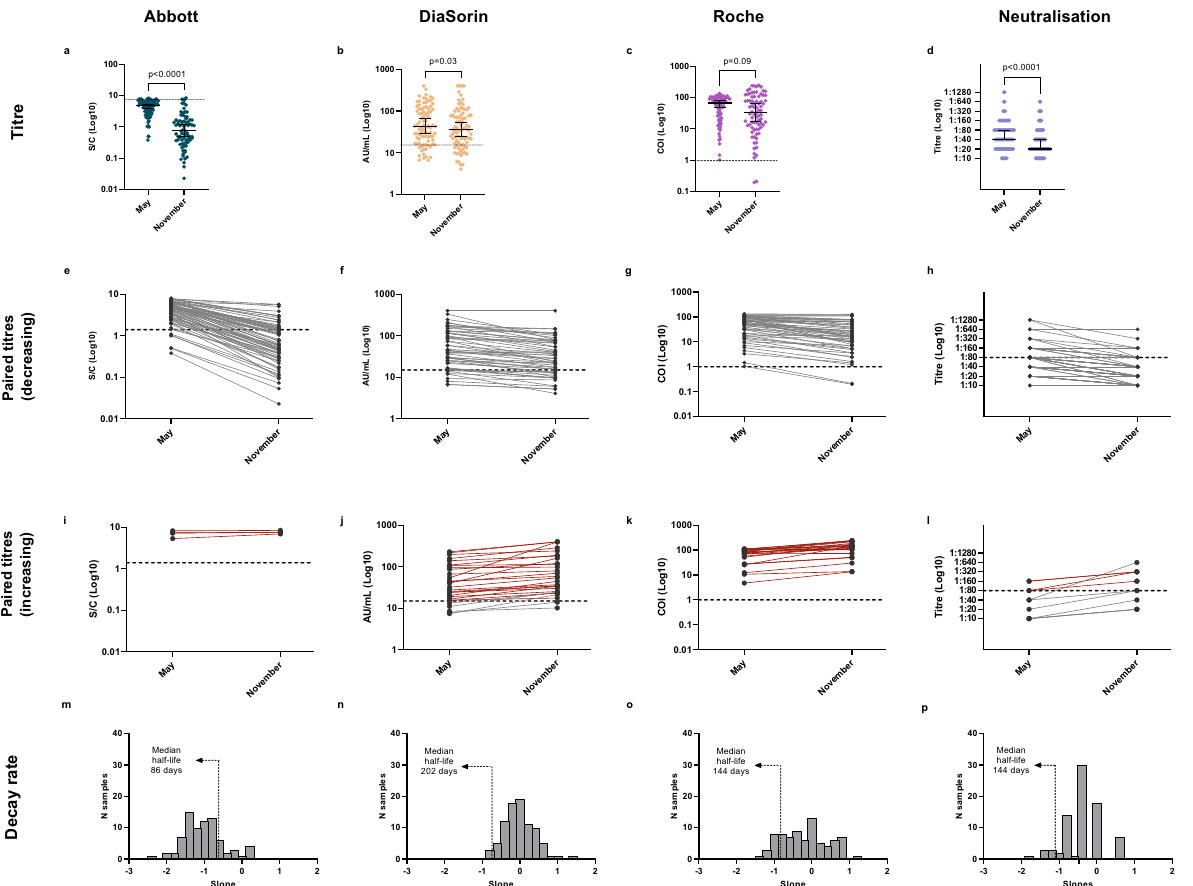
Fig. 3 Antibody titres and dynamics at nine-month post-infection follow up. a – d Observed antibody titres among subjects testing positive in May and re- tested in November by Abbott ( n = 78), DiaSorin ( n = 86), Roche ( n = 78), and micro-neutralisation assays (84), respectively (two-sided Wilcoxon signed-rank test). Only subjects belonging to the baseline ground truth de fi nition have been included. The horizontal line represents the median, the vertical line represents the 95% con fi dence intervals. e – l Antibody dynamics of individual subjects testing positive between May and November, by Abbott, DiaSorin, Roche, and micro-neutralisation. 88.9% (64 out of 72, 95% CI 79.3 – 95.1%), 20.5% (15 out of 73, 95% CI 12.0 – 31.6%), and 35.9% (28 out of 78, 95% CI 25.3 – 47.6%) of individuals showed a reduction of antibody titre of 50% or more by November when tested with Abbott, DiaSorin, and Roche, respectively, whereas 34.7% (25 out of 72, 95% CI 23.9 – 46.9%), 89.0% (65 out of 73, 95% CI 79.5 – 95.1%), and 97.4% (76 out of 78, 95% CI 91.0 – 99.7%) of subjects were still positive in November. For the micro-neutralisation assay, 41.0% (16 out of 39, 95% CI 25.6 – 57.9%) of subjects had their neutralising titres decreased by at least two dilution factors by November, and 46.1% (18 out of 39, 95% CI 30.1 – 62.8%) who had a titre greater than 1:40 (1/dil) in May still preserved that level by November. Subjects with an increasing trend between the two timepoints are shown separately in panels ( i – l ), where red lines highlight individuals who tested positive in May and showed an increase in their antibody titres by November (38 subjects in total, 1 for Abbott, 24 for DiaSorin, 23 for Roche, and 4 for micro-neutralisation). m – p Distribution of the estimated antibody decay rates. Among the subjects with a positive serological test result in May and excluding the subjects with a doubling antibody titre between May and November, we estimated a median half- life of 86 (95% CI 73 – 94) days, 202 (95% CI 140 – 270) days, 144 (95% CI 114 – 217) days, and 144 days (95% CI 117 – 178) for the antibodies detected by the Abbott, DiaSorin, Roche, and micro-neutralisation assays, individuals (9 out of 16, i.e., 56.3% 95% CI 29.9 – 80.2%) reported